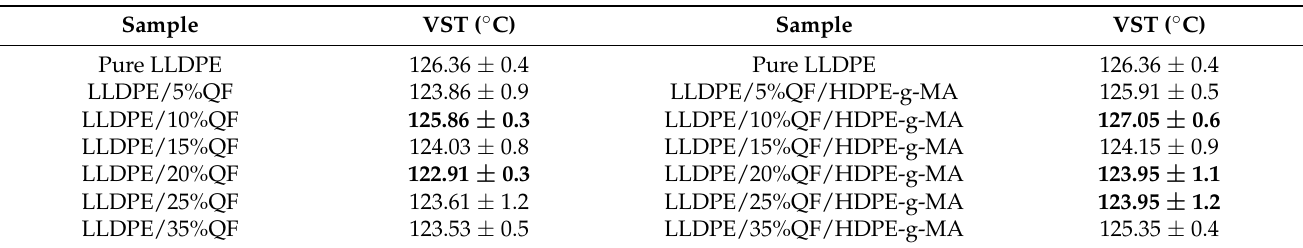
Table 4. Vicat softening temperature (VST).